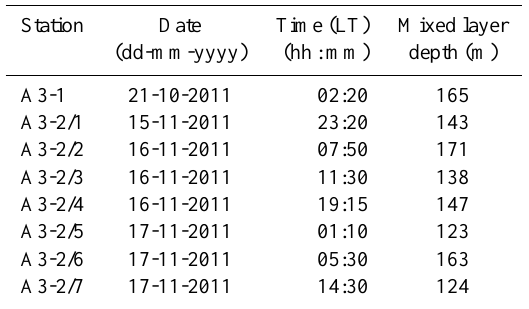
Table 1. Date and time of the casts performed at Station A3.